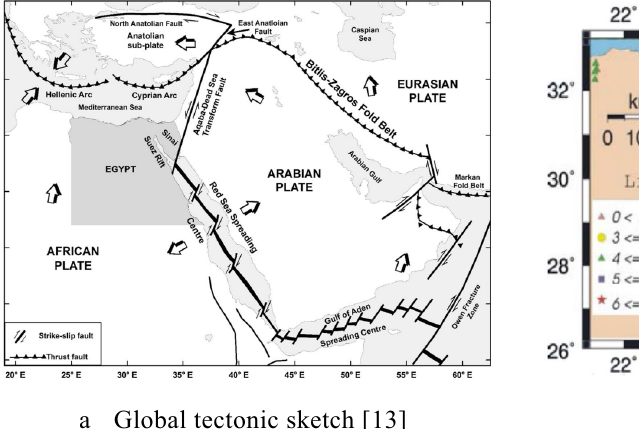
a Global tectonic sketch [13] b Seismic Activity in Northern Part [7] Fig. 2 Tectonic setting and seismic activity in